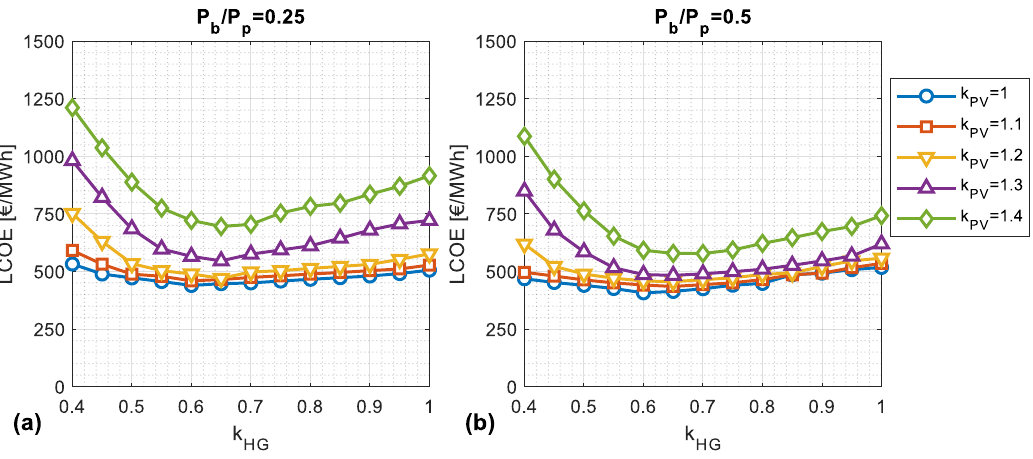
Figure 11. Levelized cost of energy as a function of k HG and different k PV values for P b /P p = 0.25 ( a ) and P b /P p = 0.5 ( b ). Energies 2020 , 13 , x FOR PEER REVIEW 14 of 19